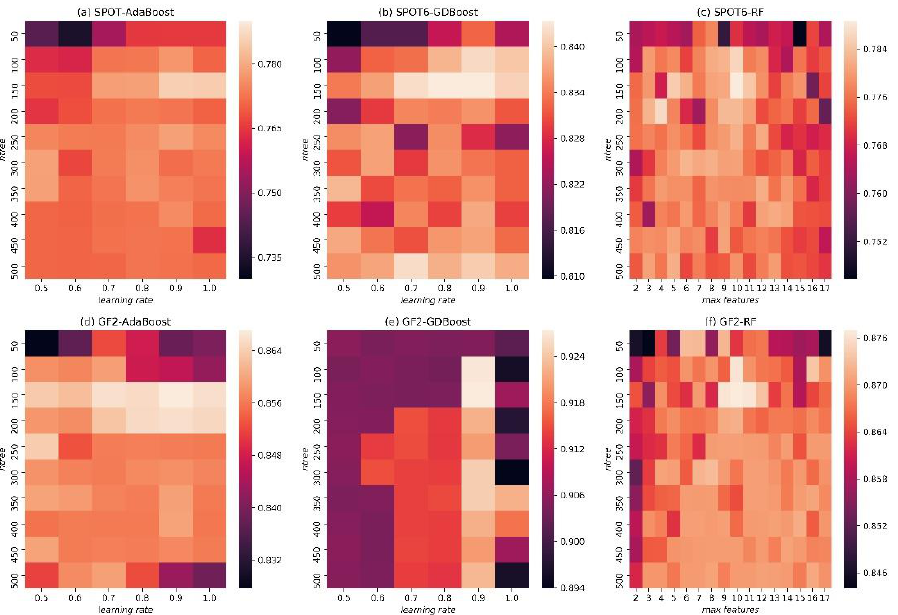
Figure 4. The coefficient of determination (R 2 ) heat map of the search space in the grid search with SPOT6, GF2 images, and different models. ( a ) R 2 heat map with the AdaBoost model in SPOT6 ( b ) R 2 heat map with the GDBoost model in SPOT6 ( c ) R 2 heat map with the RF model in SPOT6 ( d ) R 2 heat map with the AdaBoost model in GF2 ( e ) R 2 heat map with the GDBoost model in GF2 ( f ) R 2 heat map with the RF model in GF2. ( ntree represents number of trees, learning_rate represents learning rate and max features represents the size of random subsets of features to consider in constructing trees.